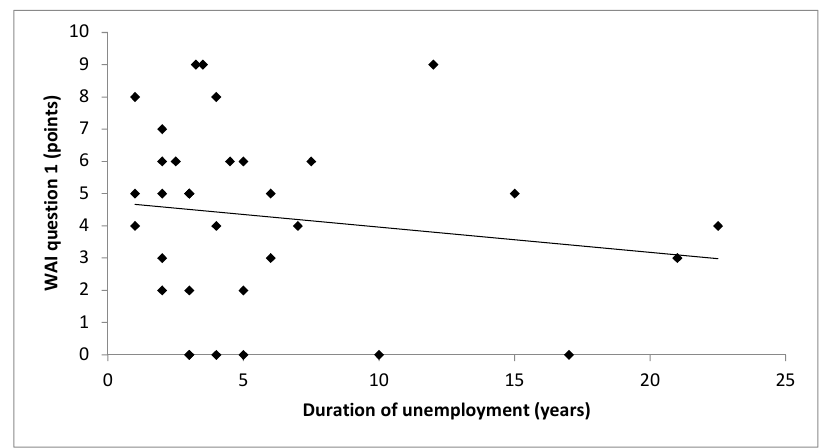
Figure 1. Scatter diagram between duration of unemployment and self-perceived work ability (WAI question 1) including a regression line. WAI: work ability index.